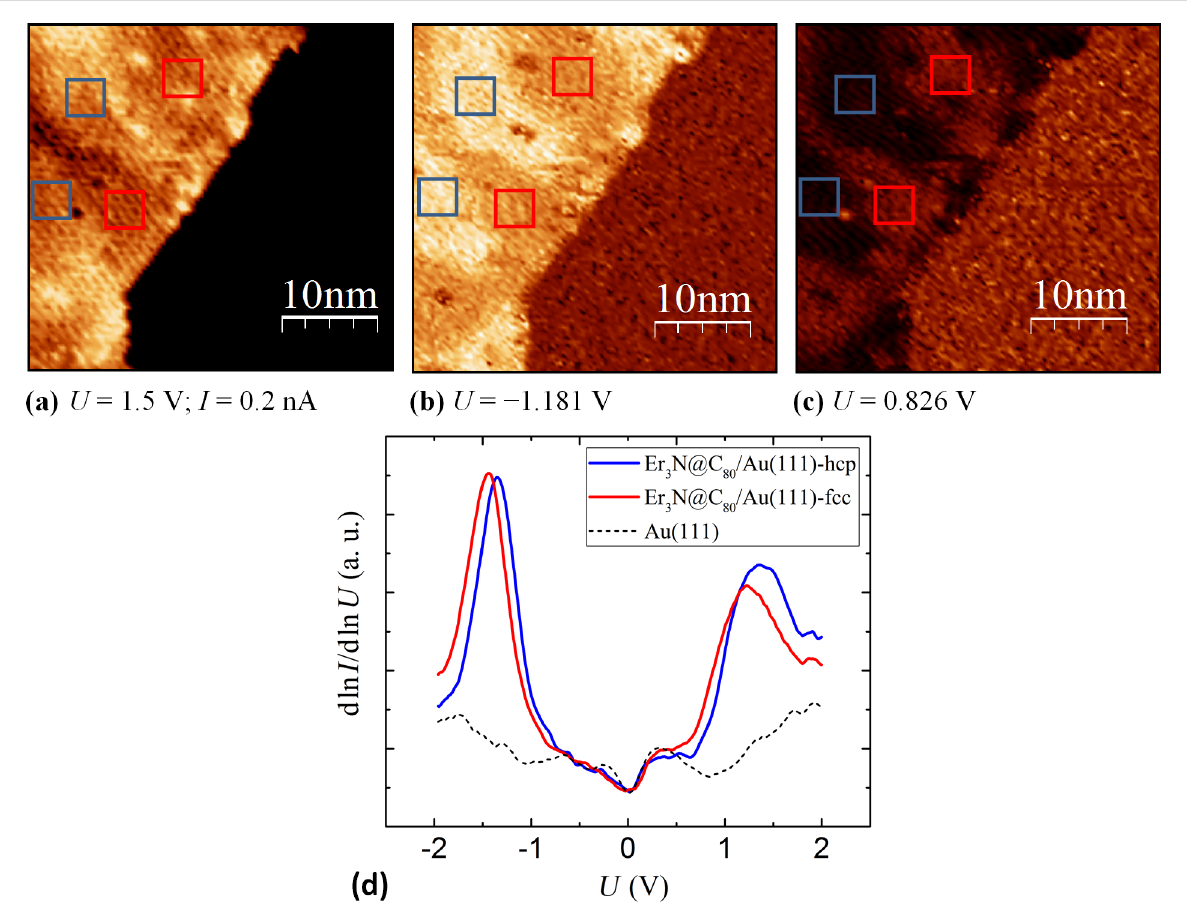
Figure 5: The left half of the constant-current-image ( U = 1.5 V; I = 0.2 nA) (a) shows an Er 3 N@C 80 -monolayer and the pristine Au(111)-surface (right half). The corresponding d I /d U -maps at the voltages (considered as applied to the sample) of U = − 1.181 V (b) and U = 0.826 V (c), reveal a bright dark pattern at the interface region accordingly to the interfacial reconstruction which is slightly visible in (a). The comparison of the dln I /dln U -spectra (d) (sample bias) taken at the highlighted (red respectively blue squares) areas in (a), (b) and (c), illustrate the spatial difference of the electronic